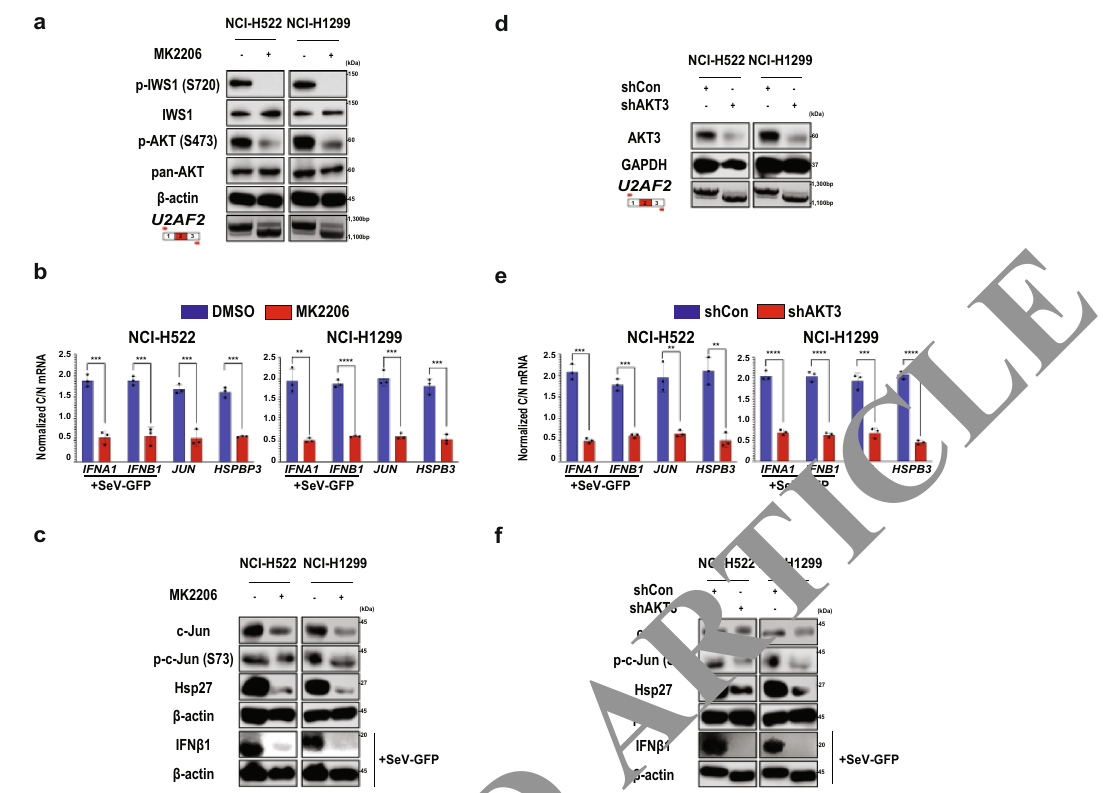
Fig. 2 The phosphorylation of IWS1 by AKT3 is required for the U2AF2 RNA splicing-dependent nuclear export of intronless gene mRNAs. a Inhibiting AKT interferes with the inclusion of exon 2 in mature U2AF2 mRNA transcripts. NCI-H522 and NCI-H1299 cells were treated with MK2206 (5 μ M) or DMSO. Lysates of these cells harvested 4 h later, were probed with the indicated antibodies. Total RNA isolated from the same cells was also analyzed by RT-PCR, using oligonucleotide primers mapping in U2AF2 exons 1 and 3. b The AKT kinase regulates the nucleocytoplasmic export of intronless mRNAs, through IWS1 phosphorylation . Cells in a were infected with SeV-GFP (MOI 0.25), to induce type I IFN gene expression. Infected and uninfected cell lysates harvested 24 h later, were fractionated into cytoplasmic and nuclear fractions, and mRNA levels of the indicated genes in each fraction were measured, using qRT-PCR. RNA levels for each transcript, were normalized to 18S rRNA. Bars show the mean normalized Cytosolic/Nuclear RNA ratio±SD. c NCI-H522 and NCI- H1299 lysates of the cells in ( a ), were probed with the indicated antibodies. Type I IFNs were induced again by SeV-GFP infection, as in 2b. d The NCI- H522 and NCI-H1299 cells were transduced with lentiviral shAKT3 or shControl constructs. Lysates of these cells were probed with the indicated antibodies. Total RNA was also analyzed by RT-PCR, using primers mapping in U2AF2 exons 1 and 3. e Cells in d were infected with SeV-GFP (MOI 0.5), to induce type I IFN expression. Infected and uninfected cell lysates harvested 24 h later, were fractionated into cytoplasmic and nuclear fractions, and the abundance of the indicated mRNAs in each fraction was determined, using qRT-PCR. RNA levels, were normalized to 18S rRNA. Bars show the mean normalized Cytosolic/Nuclear RNA ratio ±SD. f NCI-H522 and NCI-H1299 lysates of cells in ( d ), were probed with the indicated antibodies. Type I IFNs were induced again by SeV-GFP infection. To validate the cellular fractionation in the experiments in b and e we measured the Cytoplasmic/Nuclear ratio of the GAPDH RNA, as in Fig. 1b (see supplementary Table 4). Experiments in ( b ) and ( e ) were done on three biological replicates, in triplicate. n.s: